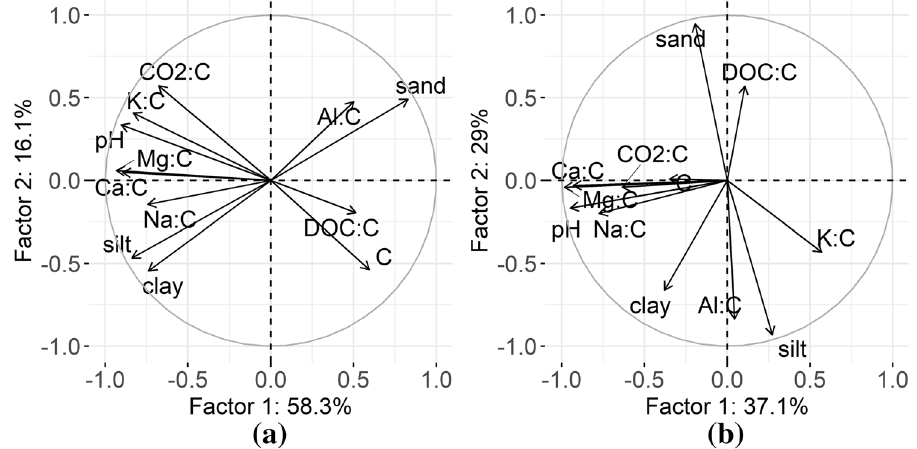
Figure 5. Two-dimensional projection of principal component analysis (PCA) for variables for soils in fir ( a ) and pine ( b )